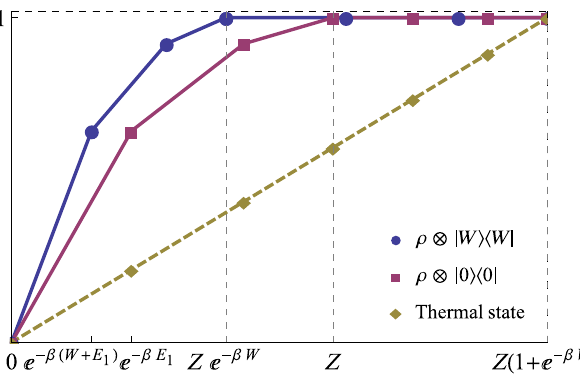
Adding this work system takes Z → Z ð 1 þ e − β W Þ , extending the x axis. When we tensor with the ground state to form ρ ⊗ j 0 ih 0 j , the curve is the same as for ρ alone, but when the excited state is tensored, there is a change in the energy levels of the β -ordering, and as a result the curve of ρ is compressed by a ratio of e − β W